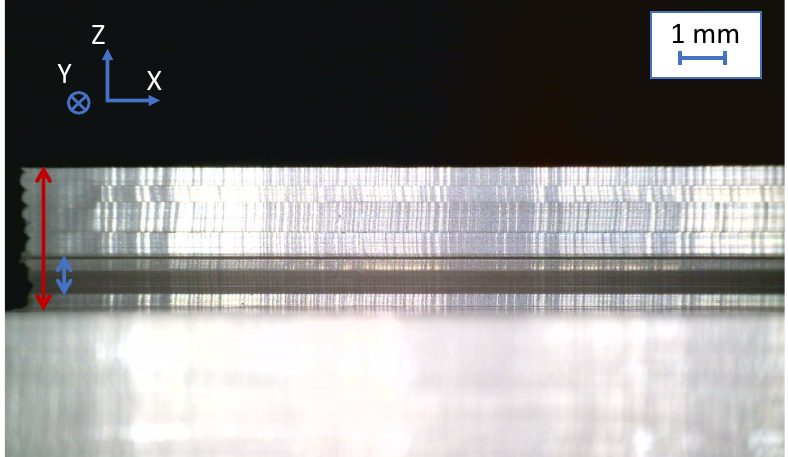
Figure 8. Surface topography of the qualification point for the tool dedicated to thermoplastics, v c = 383 m/min, f z = 0.030 mm/tooth, a p = 3 mm, and a e = 0.5 mm. No material pull-out was observed.